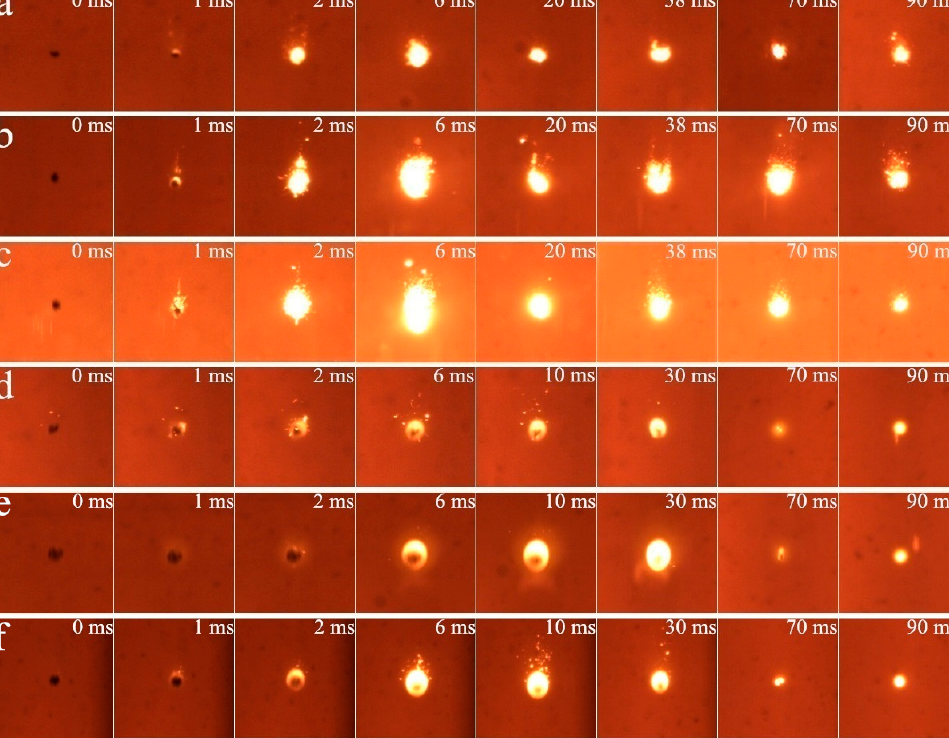
Figure 5. The influences of O 2 mole fraction on the combustion characteristics of BC and PS particles in an O 2 /H 2 O atmosphere. ( a ) BC-21%O 2 + 79%H 2 O; ( b ) BC-30%O 2 + 70%H 2 O; ( c ) BC-40%O 2 + 60%H 2 O; ( d ) PS-21%O 2 + 79%H 2 O; ( e ) PS-30%O 2 + 70%H 2 O; and ( f ) PS-40%O 2 + 60%H 2 O.